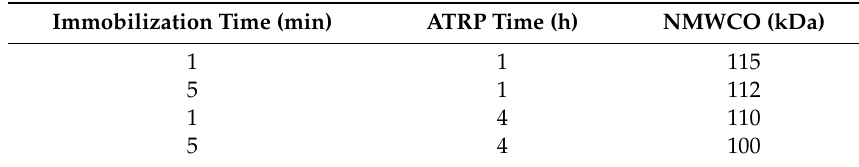
Table 1. Nominal molecular weight cuto ff (NMWCO) of modified membranes for 90% dextran rejection. ATRP: atom transfer radical polymerization.